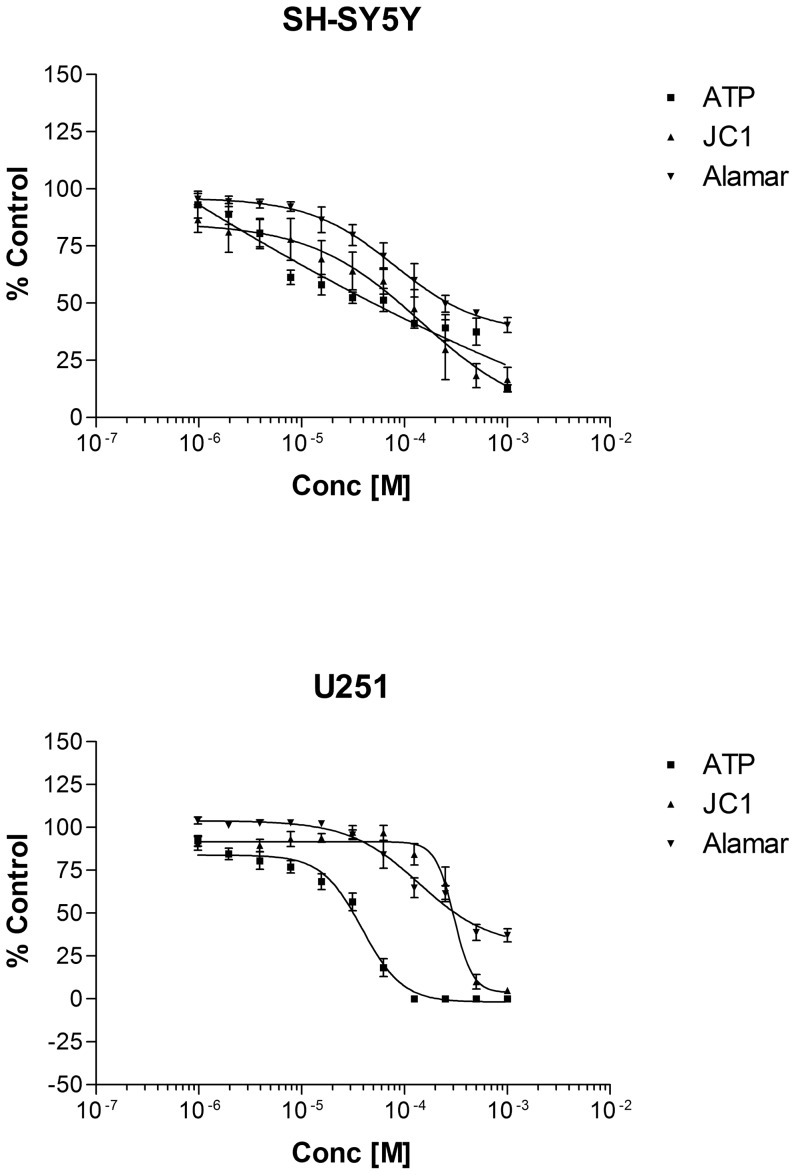
CellTiter Blue™ viability, ATP and JC-1 determinations expressed as a percentage of control values after the incubation of SH-SY5Y and U251 cells with a mixture of pyrimethanil, cyprodinil and fludioxonil over 1–1000 µM over 48 h (n = 3 per determination).